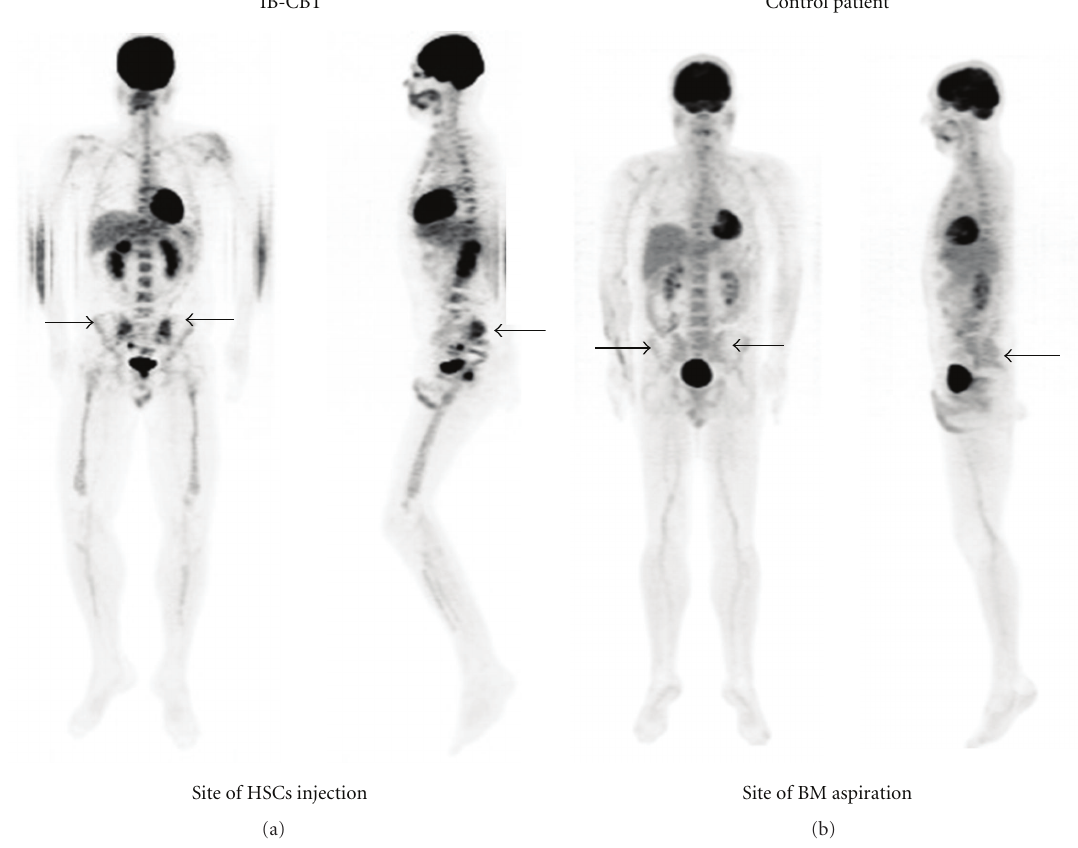
Figure 2: Whole body PET maximum intensity projections of a patient (a) and a control subject (b). Tracer retention in iliac crests is clearly visible in the patient and not in the control